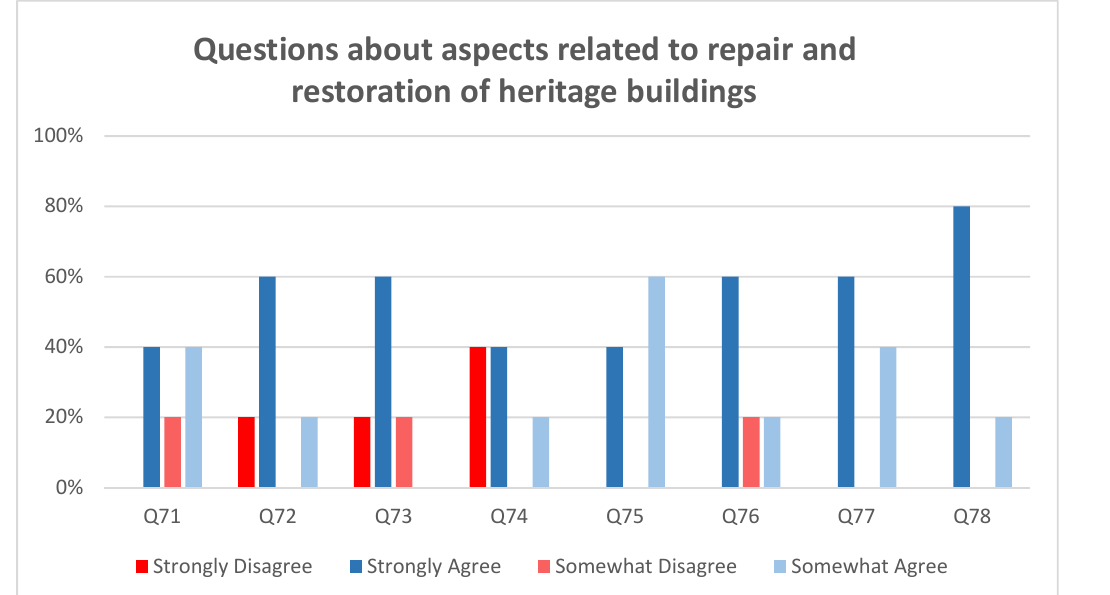
Figure 19. Results for the questions on repair and restoration of heritage buildings .